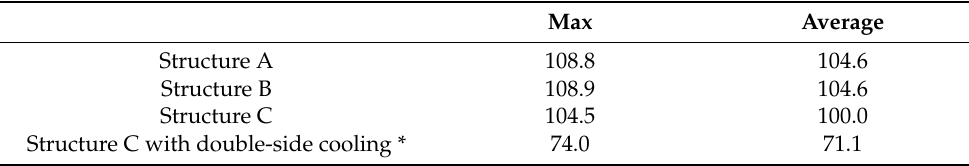
Table 3. Simulated T j as a function of package structure (all units ◦